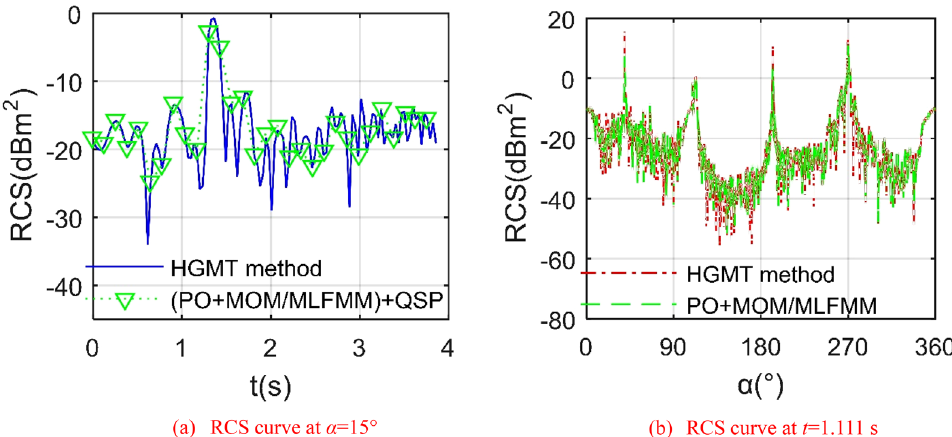
Figure 2. The Validation of HGMT on the outer wing 1, f RH = 6 GHz, β = 3°, ω r1 = 0.3142